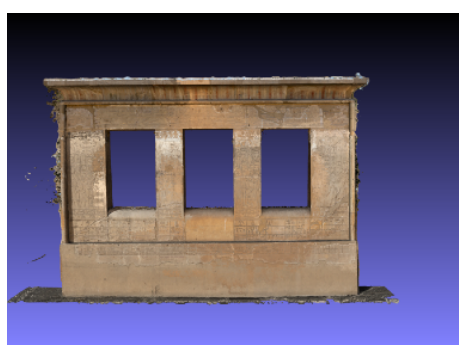
Figure 12 . Location of point markers.